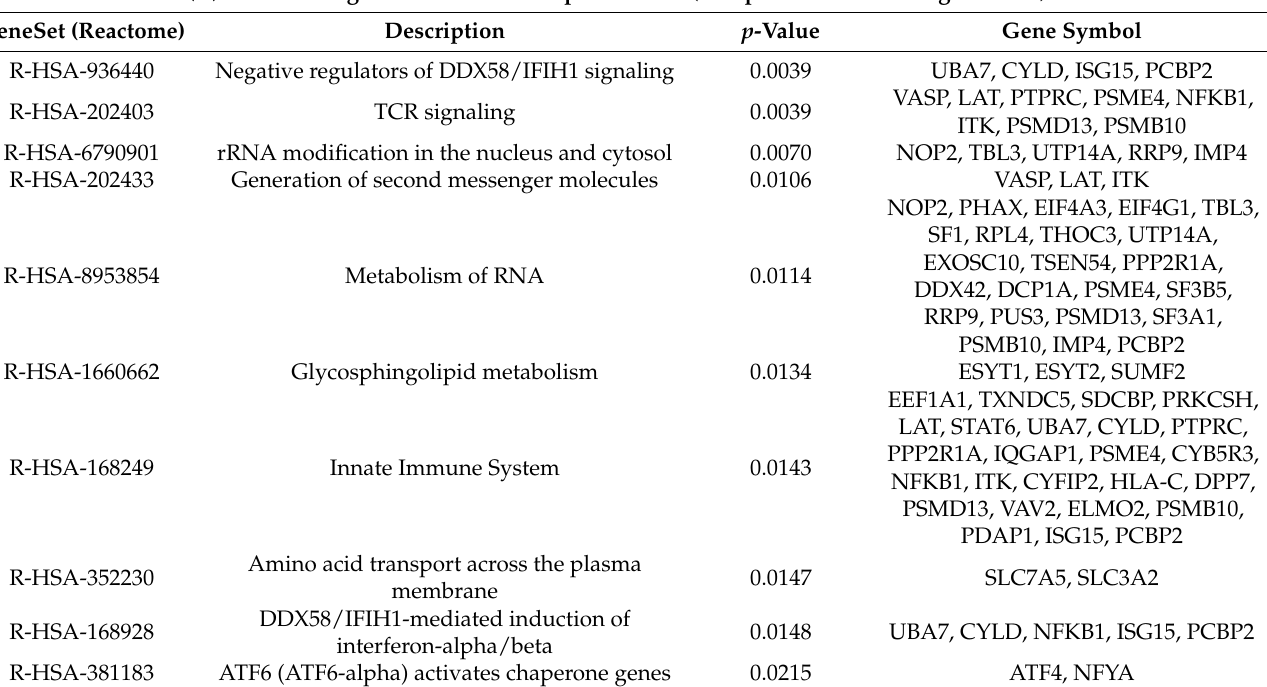
Table 2. Top 10 identified gene sets in the WebGestalt analysis for DIRAGs higher reactive in seroposi- tive (A) and seronegative RA (B) and PIA animals (C) during the disease onset period (24 days after pristane induction). The Reactome GeneSet and link to the Pathway browser, gene set description, the respective p -value and the GeneSymbols of significantly higher reactive DIRAGs are given.